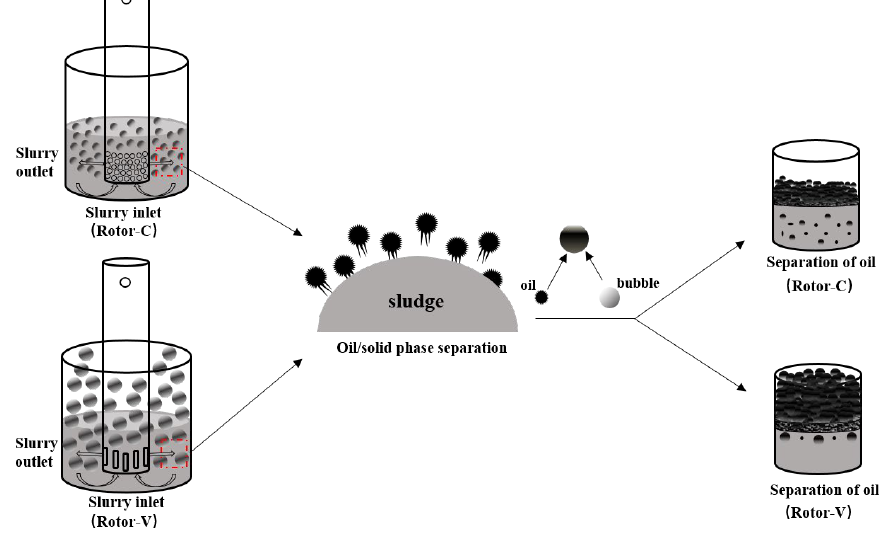
Figure 3. Schematic diagram of the oily sludge cleaning.